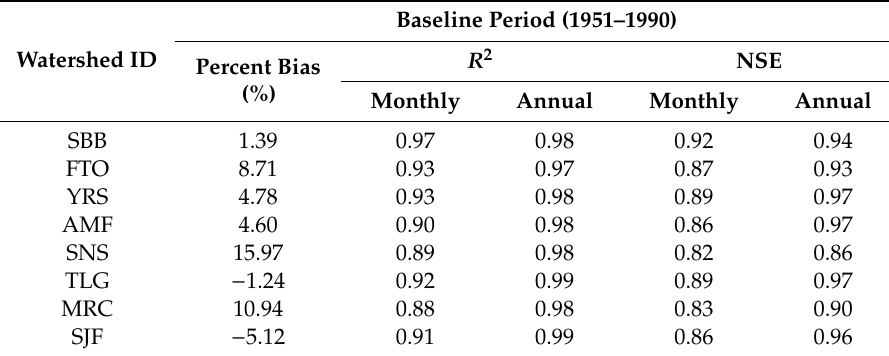
Table A3. Summary of VIC model performance during the historical baseline period.